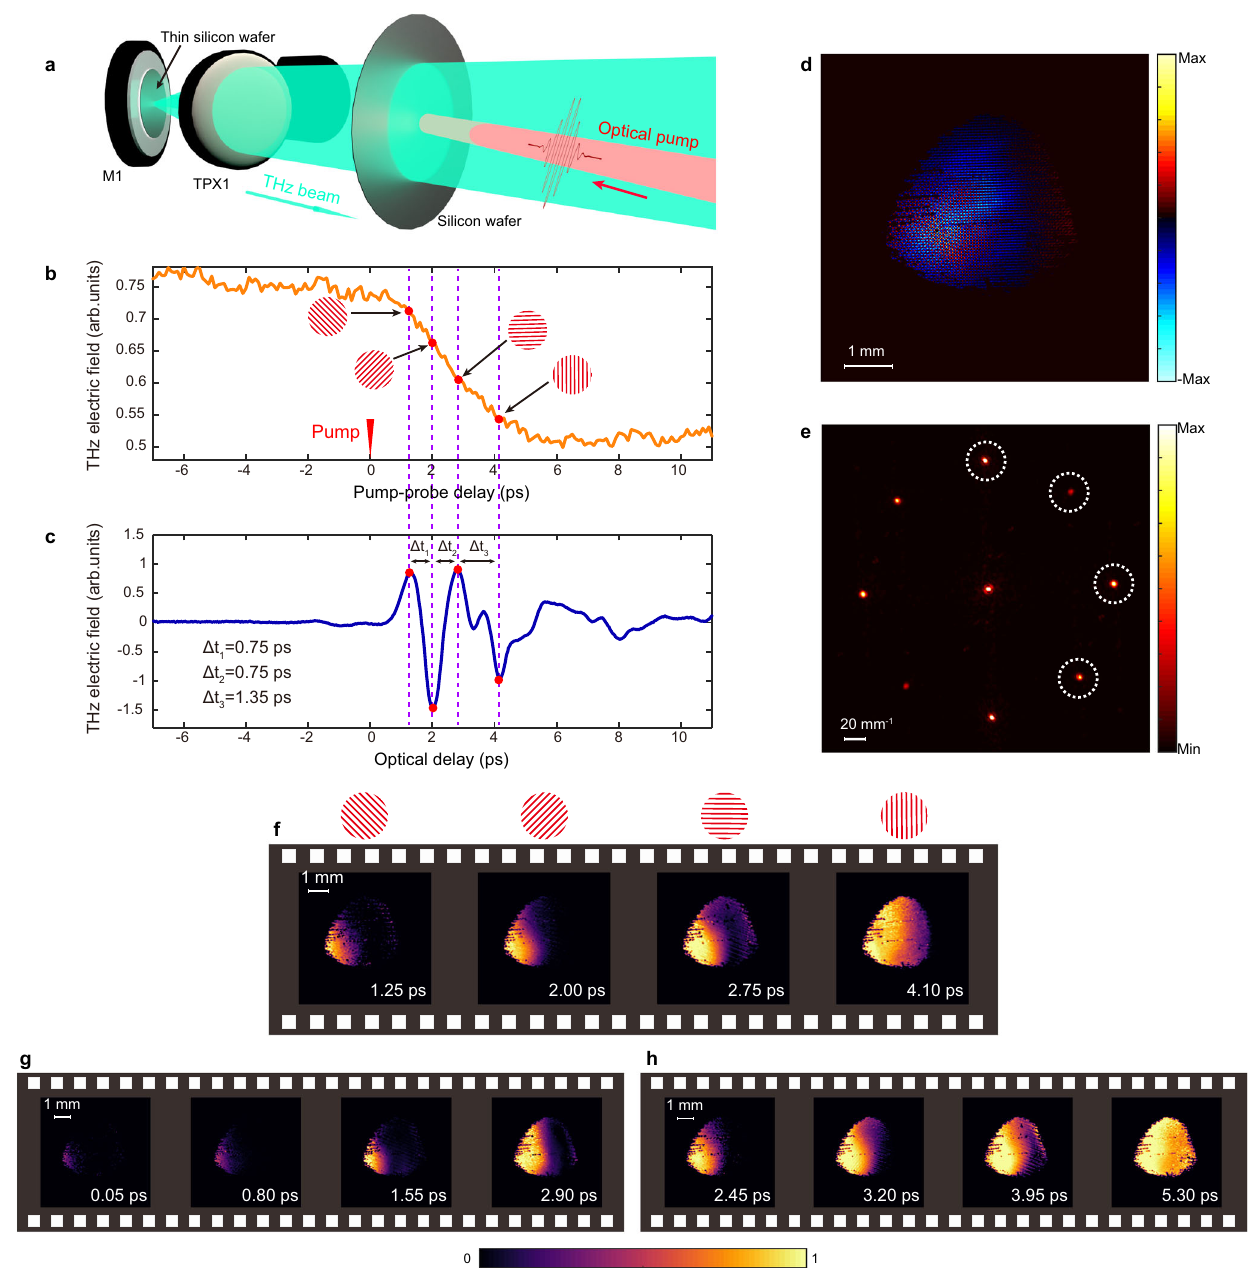
Fig.4|Ultrafastimagingofthephoto-excitedcarrierdynamicsinsilicon.a The dynamic scene we imaged was the carrier generation in an undoped silicon wafer (thickness: 500 µ m) pumped by a near-infrared laser pulse. The incident angle of the optical pump was ~30°, with a diameter of ~2mm and an average power of 50mW. b Optical pump-THz probe measurements. Note that for negative pump- probe delayvalues, the optical pumparrives after theTHz pulse. c Multi-cycleTHz pulse used for ultrafast imaging. Such a pulse was obtained by attaching a thin silicon wafer (thickness: 35 µ m) onto the mirror M1. The four sub-pulses in the multiplexed probebeam weretemporally alignedwith the four peaks of the multi- cycleTHzpulse,inturnleadingtointer-frametimeintervalsof0.75ps,0.75ps,and